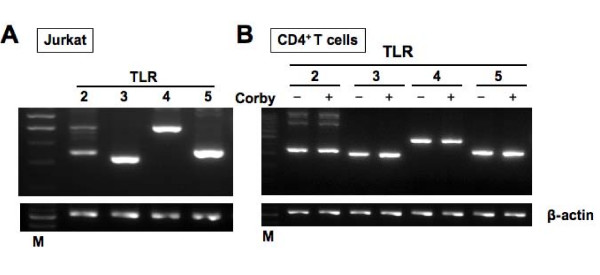
TLR mRNA expression in T cells. (A) Expression of TLR mRNA in Jurkat cells. Total RNA was extracted from Jurkat cells and used for RT-PCR. (B) CD4+ T cells were infected without or with Corby (MOI of 50) for 3 h. Total RNA was extracted from CD4+ T cells and used for RT-PCR. Representative examples of three experiments with similar results.